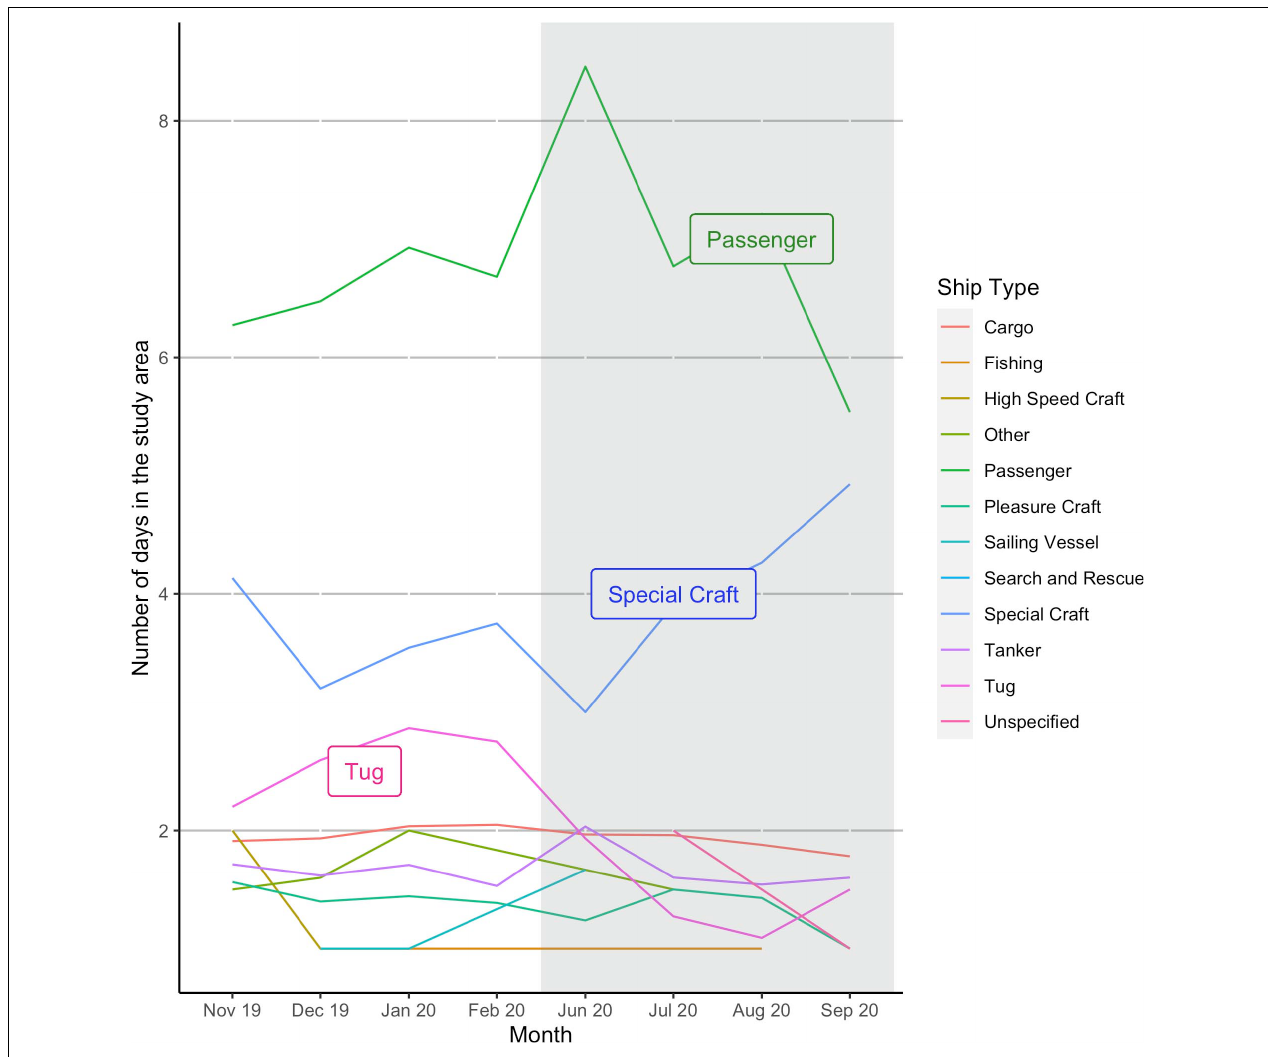
FIGURE 5 | The number of days ship types were present in the study area pre- and during COVID-19 (shaded gray), with the three ship types that had changes in behavior labeled on their respective line.